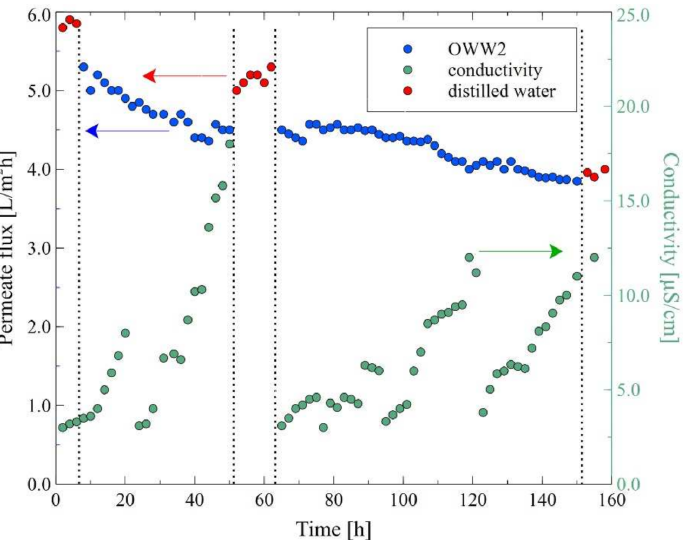
Figure 19. Changes in the permeate flux and distillate conductivity. Feed: oily wastewater OWW2, T F = 343 K, v F = 0.12 m/s. Module